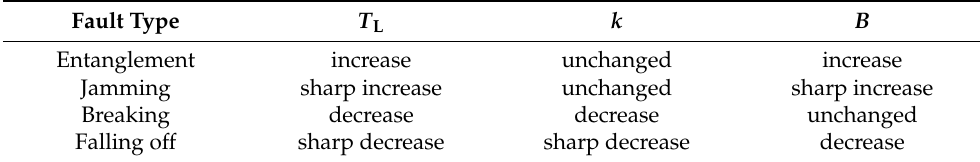
Table 1. Relationship between the fault characteristic parameters and the faults of thrusters.